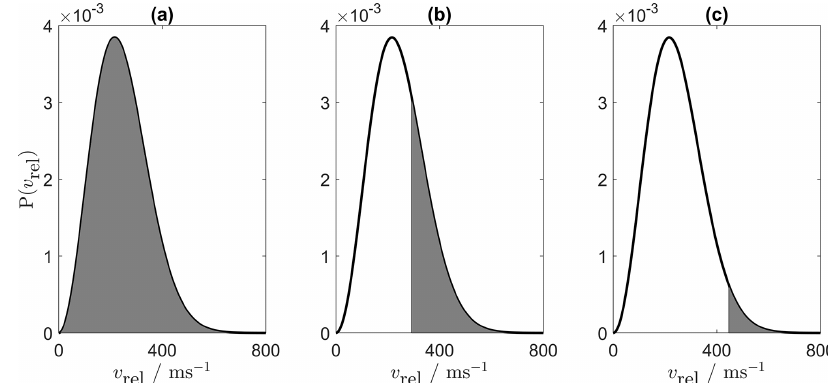
Figure 2. Aggregation probability, indicated by the shaded area, for a collision between a SiO 2 particle ( r 2 = 0 . 2nm, q 2 = − 1 e ) and an ice particle ( r 1 = 30nm), as defined by the Maxwell–Boltzmann distribution of the relative velocity at T = 150K. (a) In the case of a neutral ice particle ( q 1 = 0), the probability of aggregation is 1 as P(v rel ) is integrated in the velocity range of [ 0 , 1192 ] ms − 1 . (b) For q 1 = − 1 e , the probability of aggregation is 0.293 as P(v rel ) is integrated in the velocity range of [ 295 , 1219 ] ms − 1 . (c) For q 1 = − 2 e , the probability of aggregation is 0.034 as P(v rel ) is integrated in the velocity range of [ 450 , 1260 ] ms − 1 . The values of v min